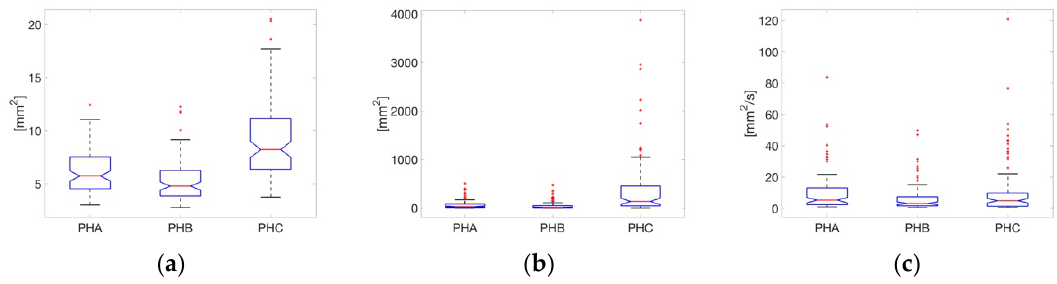
Figure 10. Mean velocity distributions for each of the three phases PHA, PHB and PHC: ( a ) MVELO distributions, ( b ) MVELOX distributions and ( c ) MVELOY distributions.